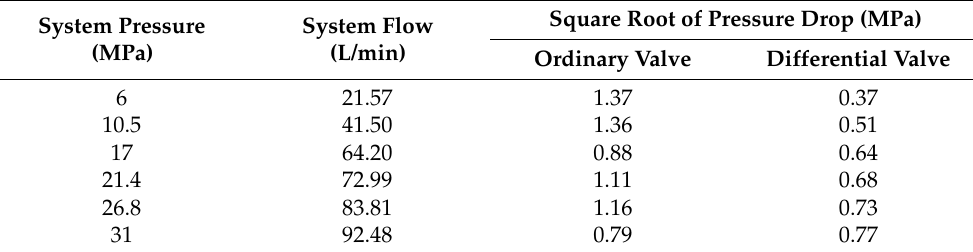
Table 3. Hydraulic cylinder retraction data between ordinary valve and differential valve.